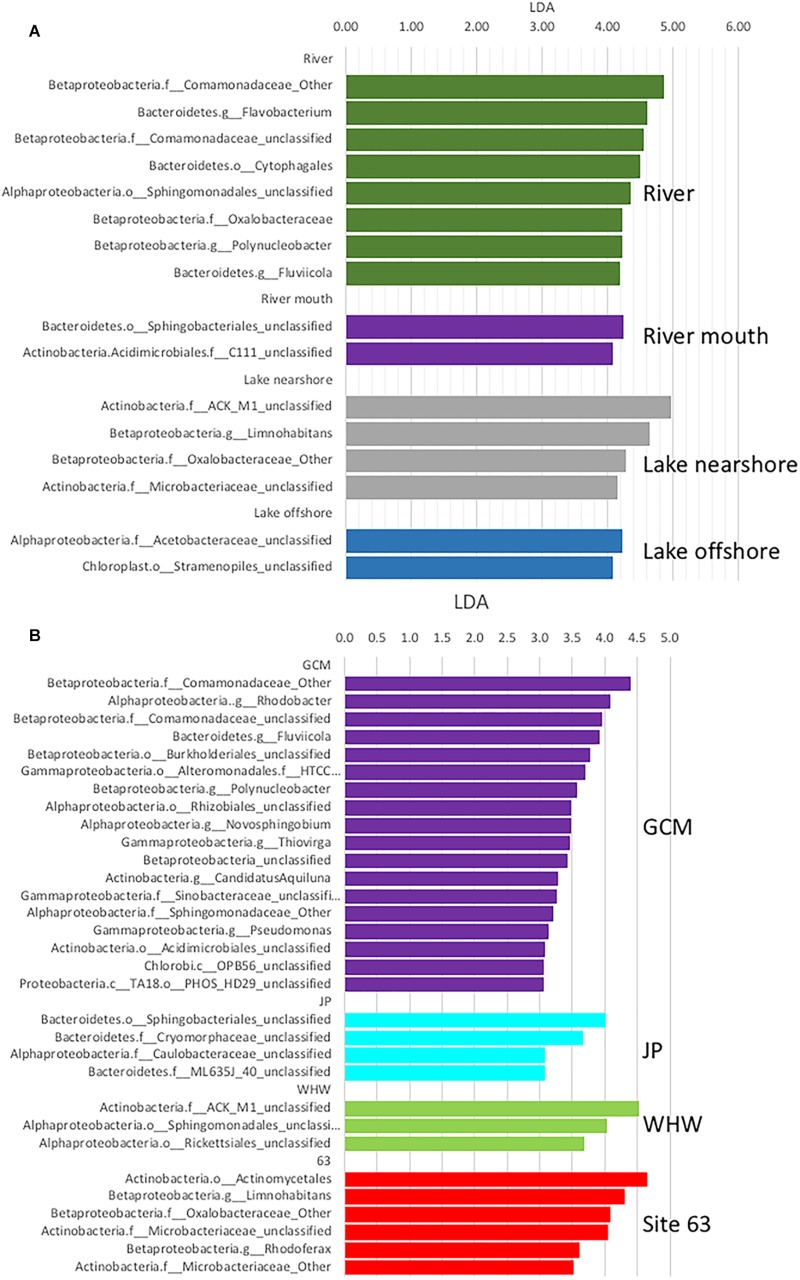
Linear Discriminate Analysis Effect Size (LEfSE) analysis of microbial communities from the various (A) water sources and (B) nearshore collection sites and river mouth. Only taxa that differed significantly (p < 0.05) with LDA effect sizes greater than 4.0 in (A) and 3.0 in (B) are illustrated in the histograms. Taxa names include phylum followed by lowest taxonomic assignment available. Nearshore beaches include Jeorse Park (JP), Whihala (WH), and 63rd Street (63) in Chicago, and mouth of the Calumet River (GCM).